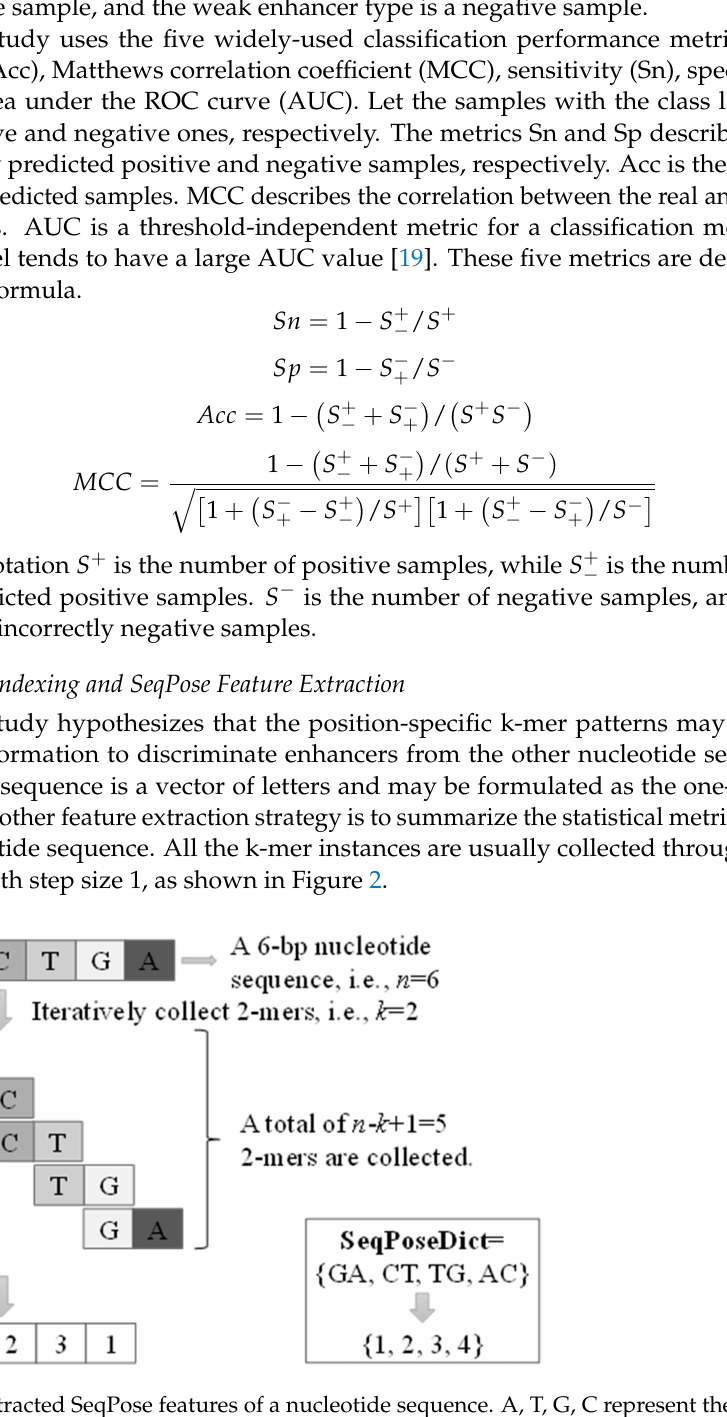
Figure 2. Extracted SeqPose features of a nucleotide sequence. A, T, G, C represent the bases in the nucleotide